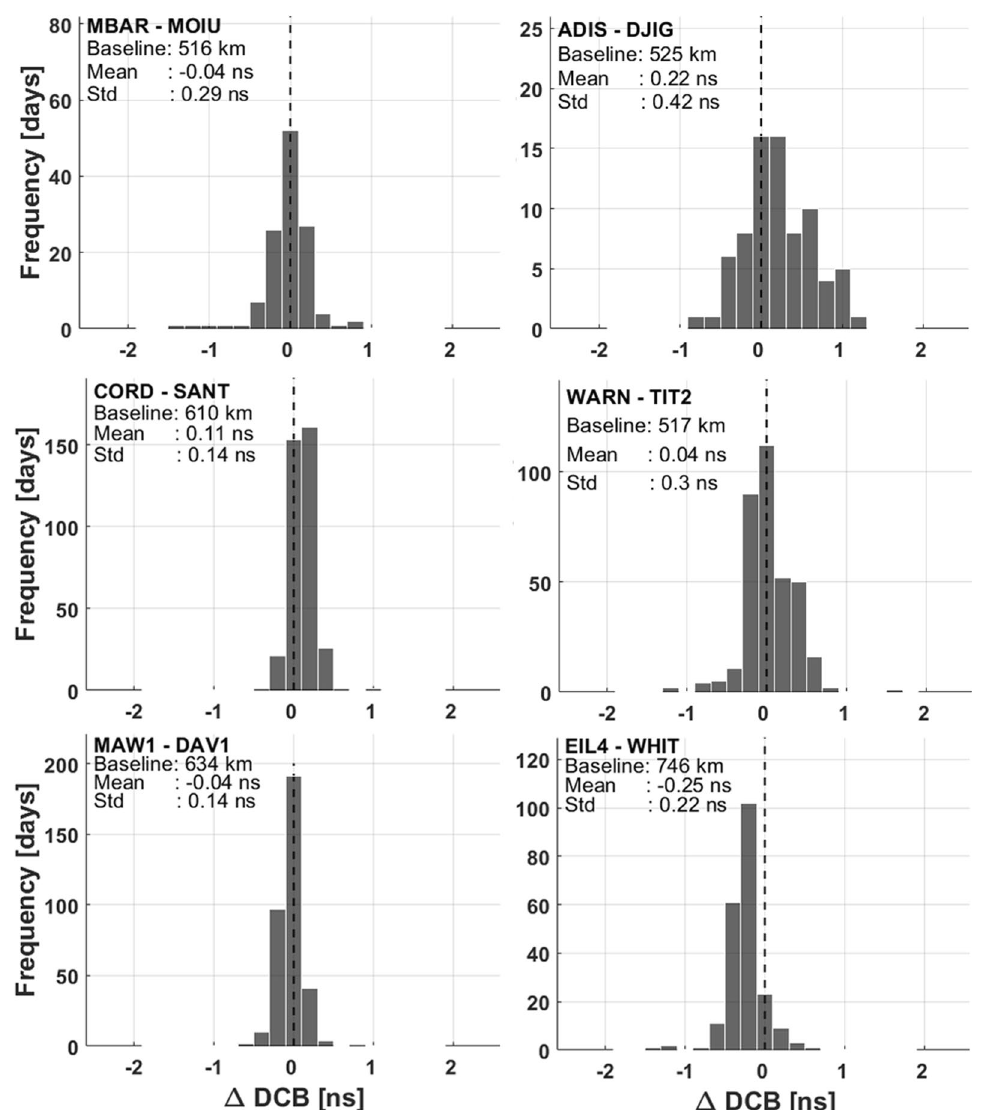
Fig. 3 For low-, mid-, and high-latitude station bias calculation. Top row shows results for low-latitude, middle one for mid-latitude and bottom one for high latitude stations, respectively. Participating station pair’s codes are shown in the top left corner of each panel. Baseline distance between the two participating stations, mean and standard deviation of calculation errors are also shown at the top left corner. The frequency axis on each plot is different and set according to the number of days’ data available. The black dotted line in the middle of each plot shows the zero difference line between calculated and available station